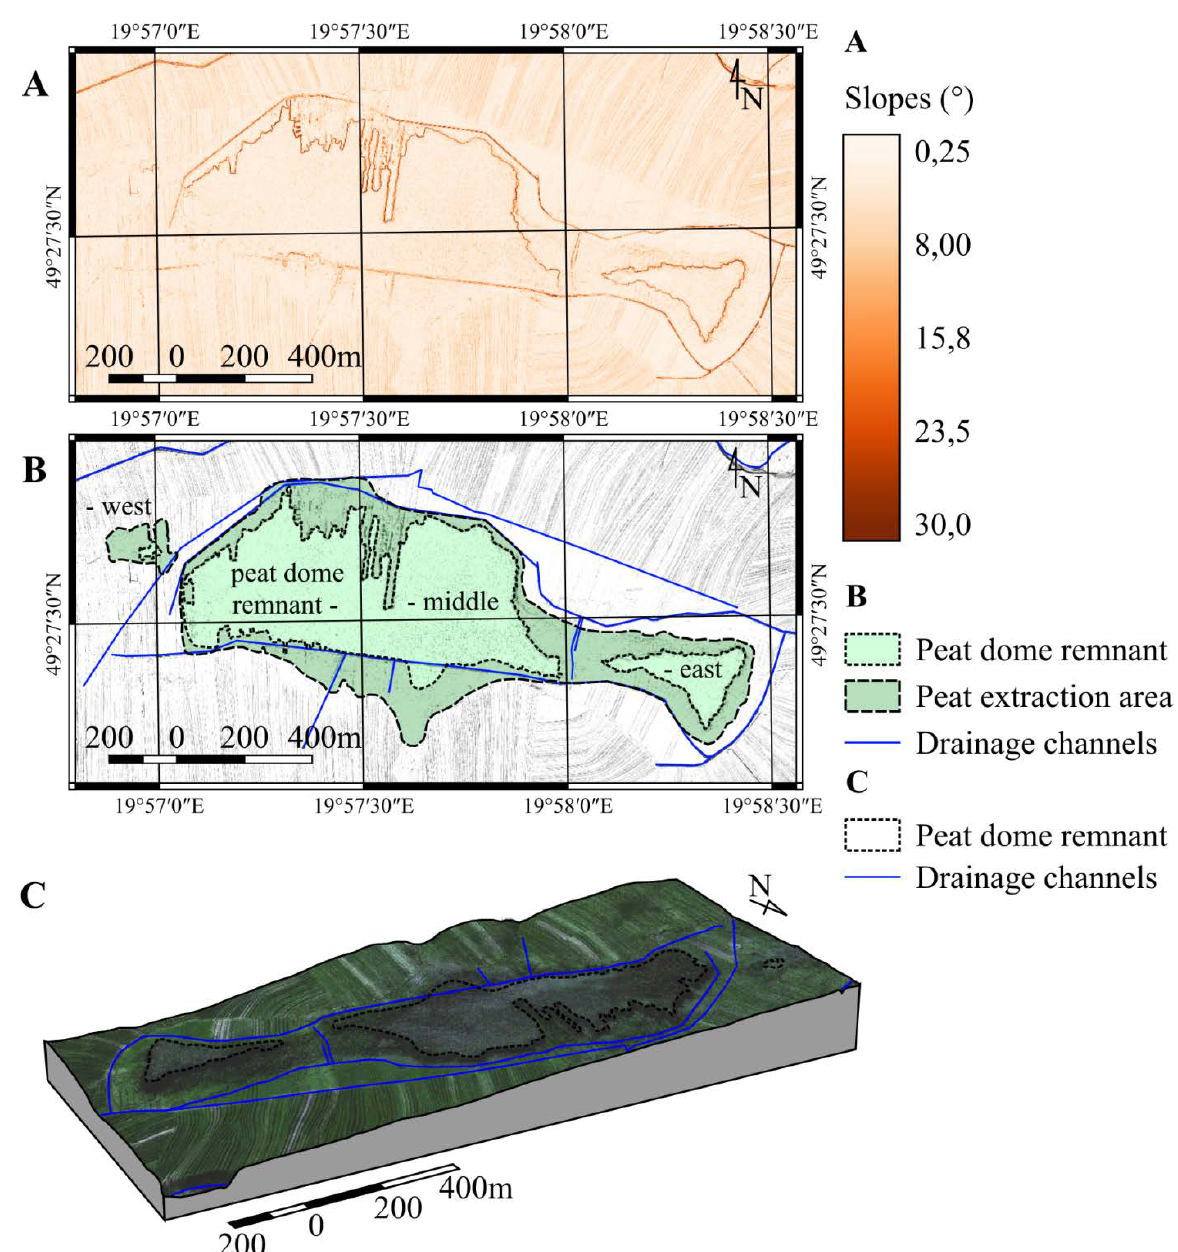
Figure 3. Ludźmierz Bog. A: slope map of study area; B: division of the bog into domes and cutover areas; C: 3D model of the study area showing natural